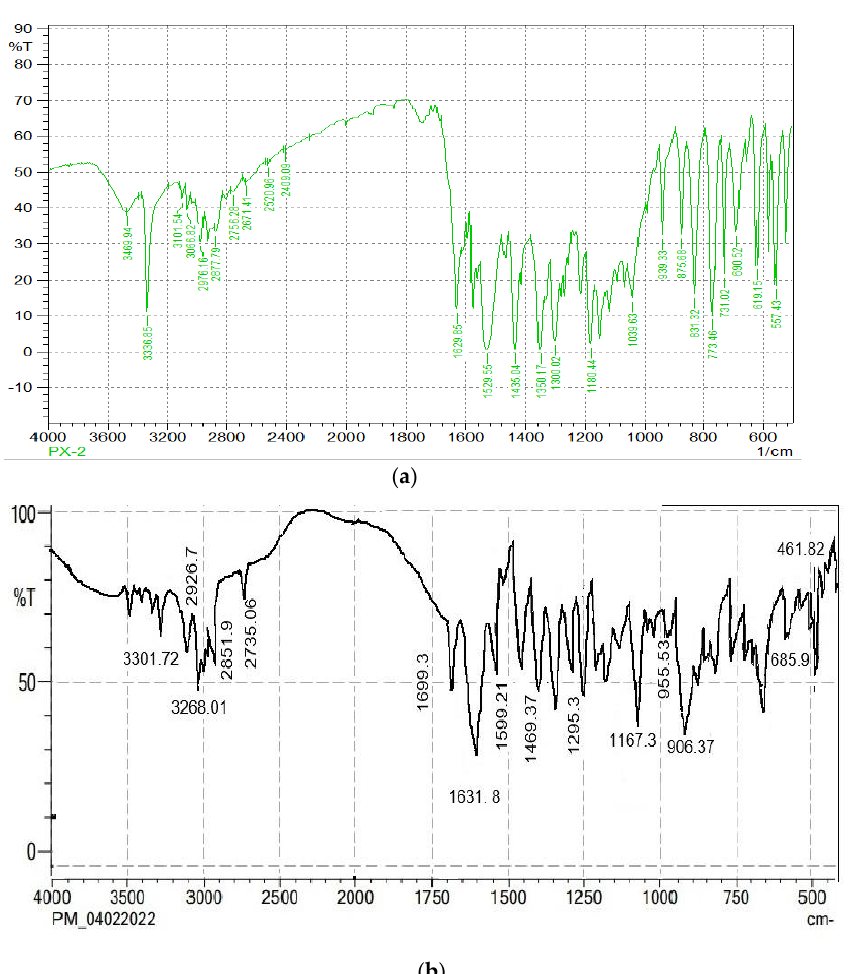
Figure 2. FTIR Spectra of ( a ) PT and ( b ) physical mixture of PT and polymers. The DSC thermogram of PT and a physical mixture of PT and polymers were obtained to assess the thermal behavior (Figure S2 ). The endothermic peak at 216 °C, which corresponds to the melting point of 216 – 217 °C, defines PT. Physical mixtures have also shown a similar endothermic peak with a slight variation (at 214 °C), supporting the un- changed thermal behavior of PT with particular polymers.